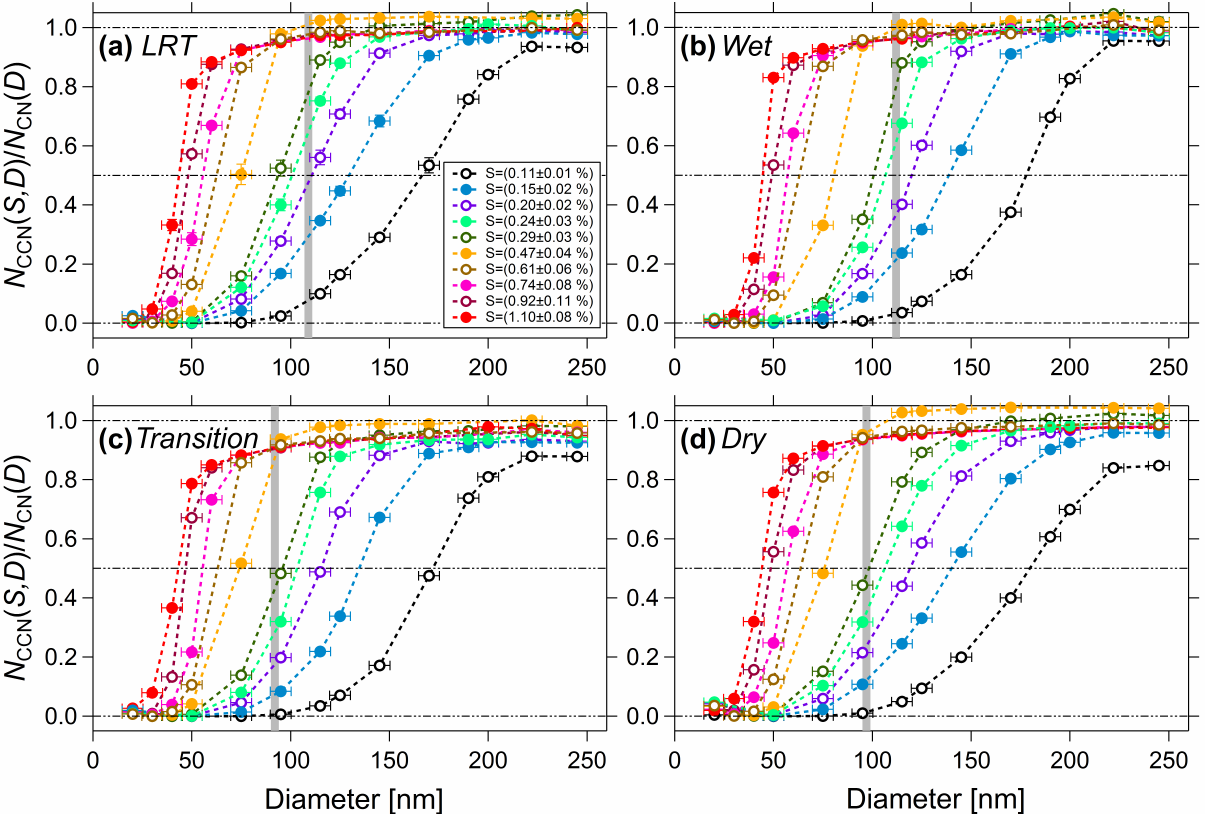
Figure 5. CCN activation curves for all measured S levels ( S = 0.11–1.10%), subdivided into seasonal periods of interest as specified in Sect. 3.3. Data points represent arithmetic mean values. For N CCN ( S,D )/ N CN ( D ), the standard error is plotted, which is very small (due to the large number of scans with comparatively small variability) and therefore not perceptible in this representation. For the diameter, D , the error bars represent the experimental error as specified in Sect. 2.3. The grey vertical bands represent the (seasonal) position of the Hoppel minima (including error range; compare to Table 2). Dashed horizontal lines provide visual orientation and indicate 0, 50, and 100% activation. The 50% activation diameter is used for calculation of the hygroscopicity parameter κ ( S , D a ) . The lines connecting the data points merely serve as visual